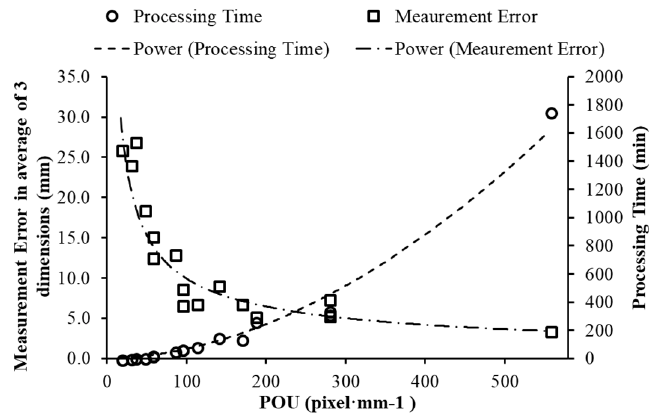
Figure 8. Comparison between processing time and measurement errors. The errors are the averages for all three replicates of all three shapes and all three dimensions, and processing time is based on the first replicate of reconstructing the 3D models. Table 5. Number of points for each object using the highest and lowest POU .